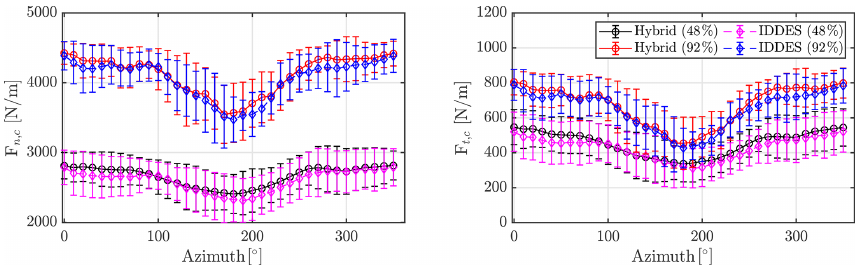
Figure 13. Normal and tangential forces at 48 and 92% blade length using hybrid or IDDES turbulence model. Temporal means and standard deviations based on the final 15 revolutions.